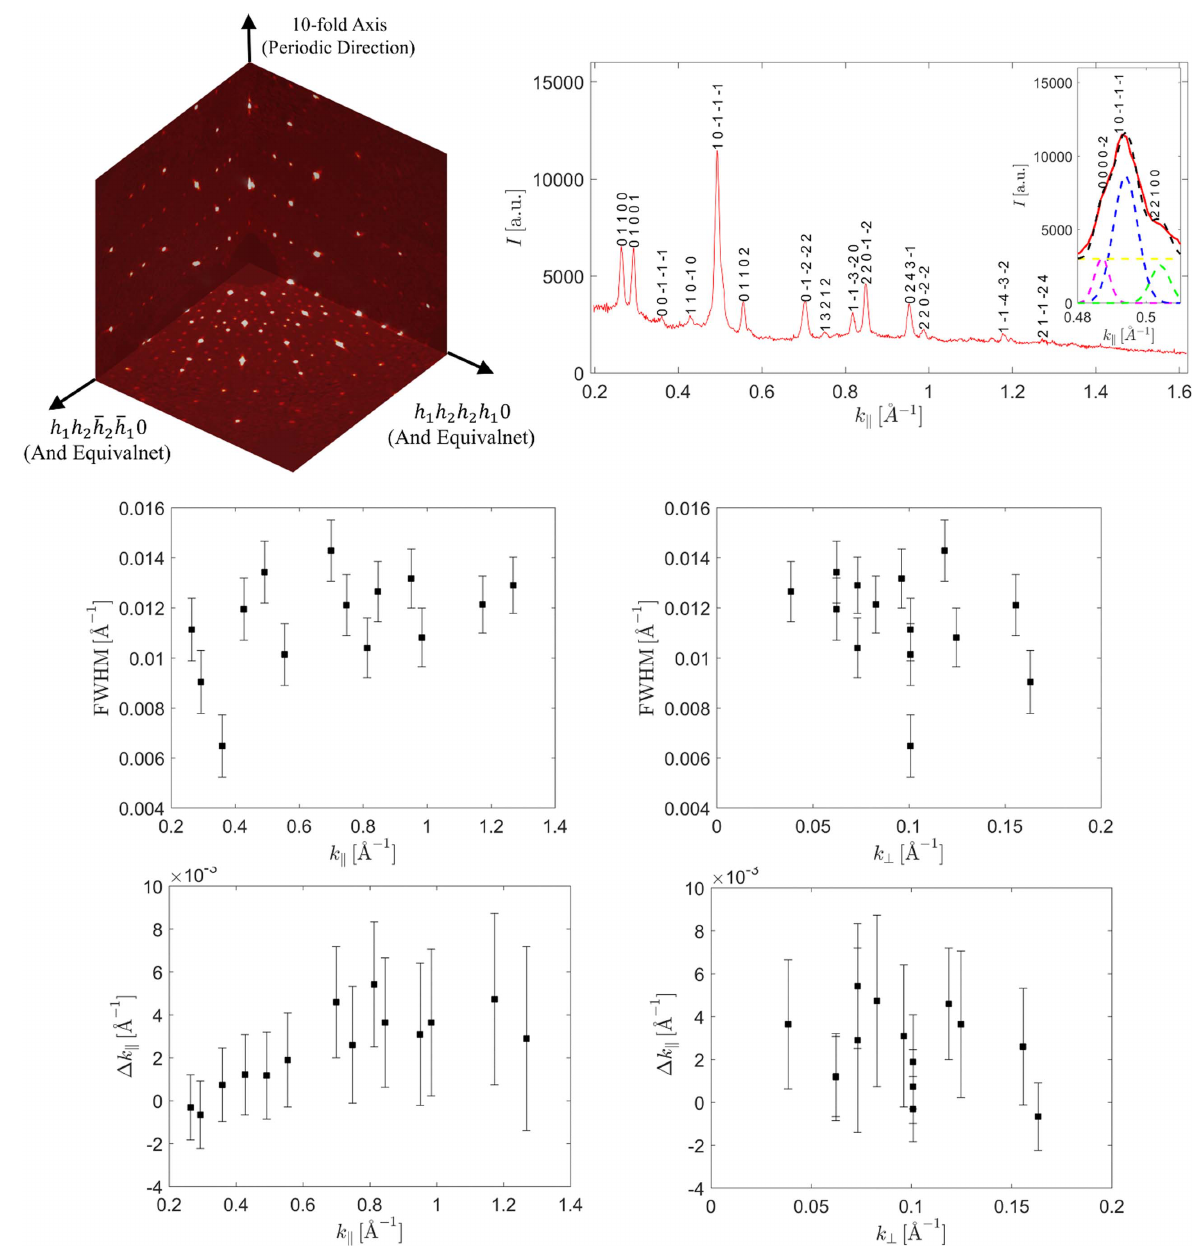
Figure 1 Analysis of the diffraction data. (Top) The planar sections through the 3D diffraction pattern and its representation in the k superstructure peak is circled with a yellow-dotted line. The profile of the peak 10111 [indexed in setting (1)] indicates it is in fact assembled out of three peaks that are not separated due to the high width of the diffraction peaks. (Mid and bottom) FWHM and the peak shift with respect to k experimental uncertainty of the measured peak characteristics makes quantitative analysis of the phason and phonon strain